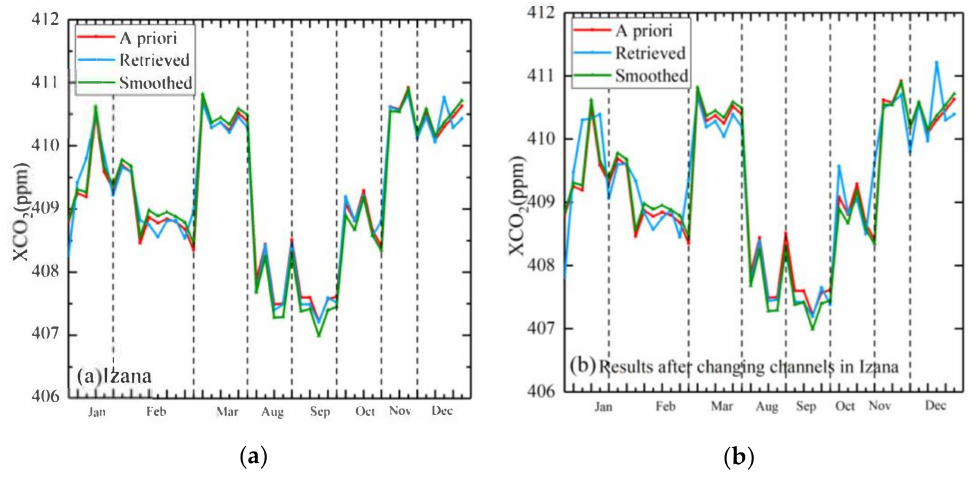
Figure 13. Comparison of Izana observations with inversion results ( a ) and inversion results using channels in high latitudes ( b ). Red line is for a priori, blue line is for CrIS inversion, and green line is for the smoothed TCCON